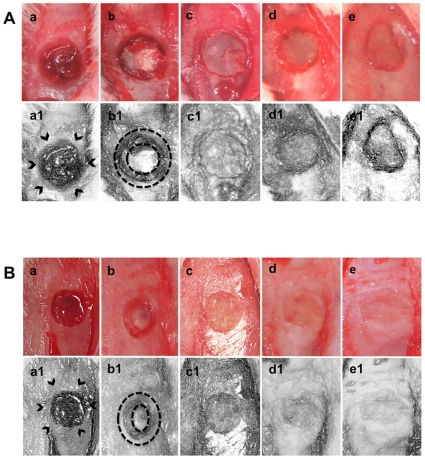
Brain swelling accompanies TBI.Following CCI, obvious brain swelling was detected in animals subjected to no skull reconstruction (Panels a and a1). Reconstruction with bone flap only provided partial skull reconstruction, thereby allowing a tempered brain swelling (Panels b and b1). Skull reconstruction with bone wax only (Panels c and c1), bone wax and bone flap (Panels d and d1), or delayed reconstruction with bone wax (Panels e and e1) afforded normalized skull structure, but also prevented visualization of brain swelling. Arrows are indicative of brain swelling following TBI. Dotted circles show the tempered brain swelling that occurred in the animals that received reconstruction with bone flap only.